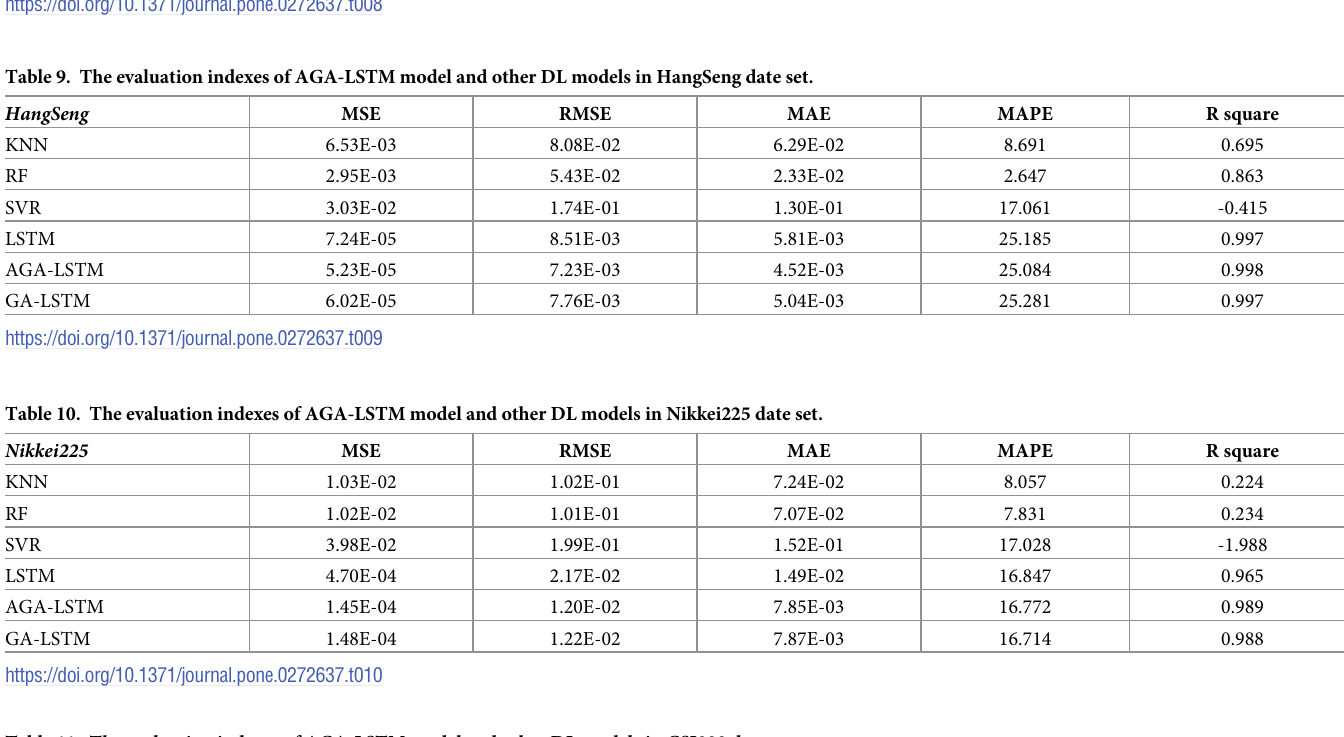
Table 11. The evaluation indexes of AGA-LSTM model and other DL models in CSI300 date set. CSI300